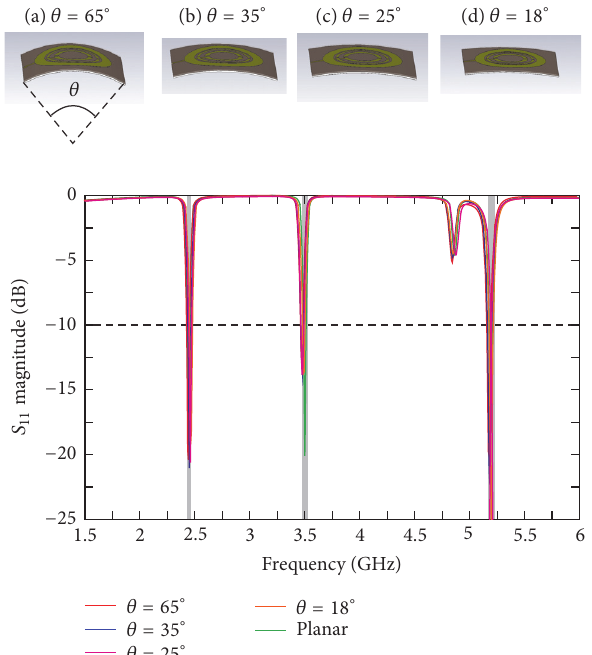
Figure 6: Frequency response of the designed antenna shown in Figure 1 for different curvature